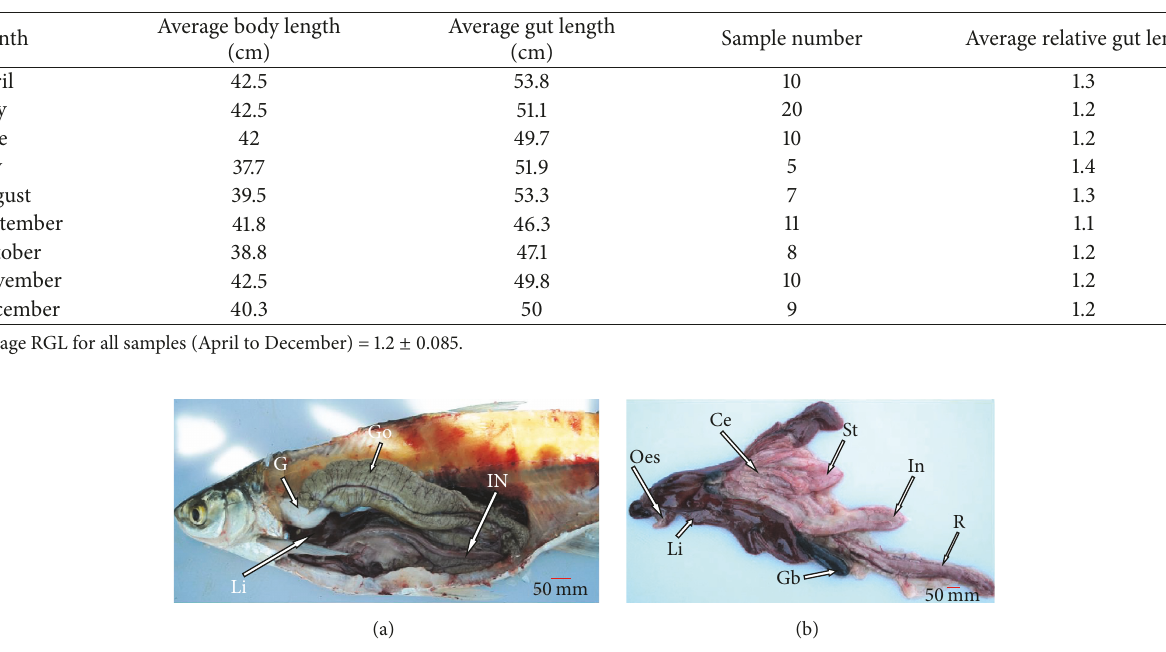
Table 1: Relative gut length of A. baremoze collected from Lake Albert, Uganda.